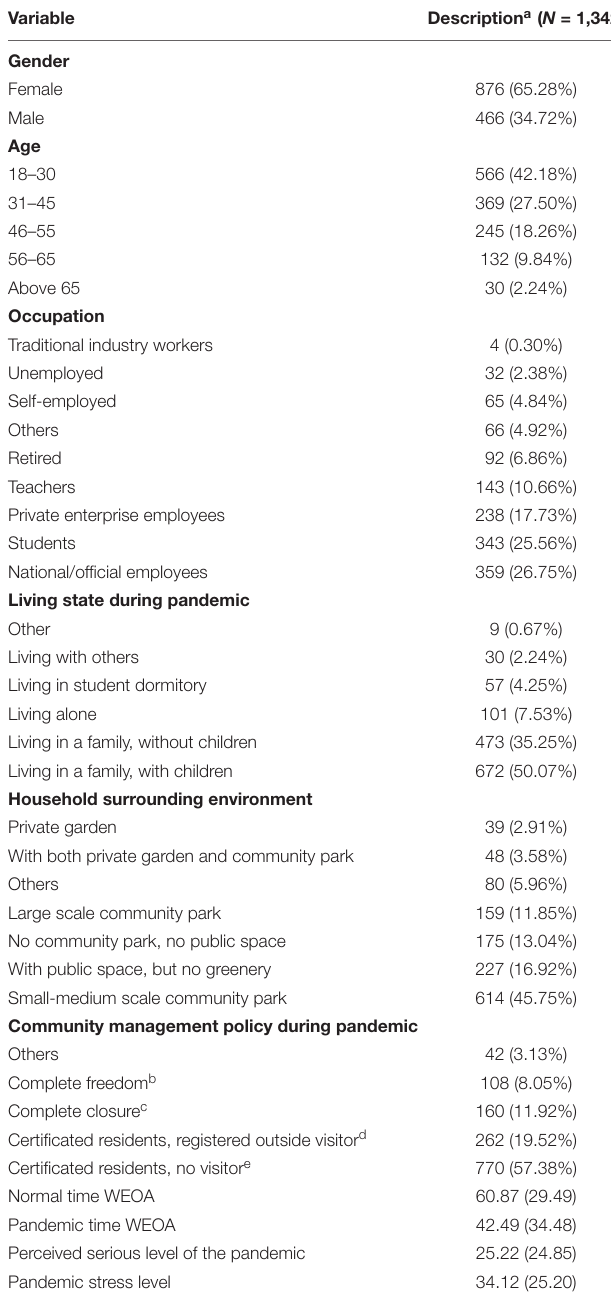
TABLE 1 | Sociodemographic